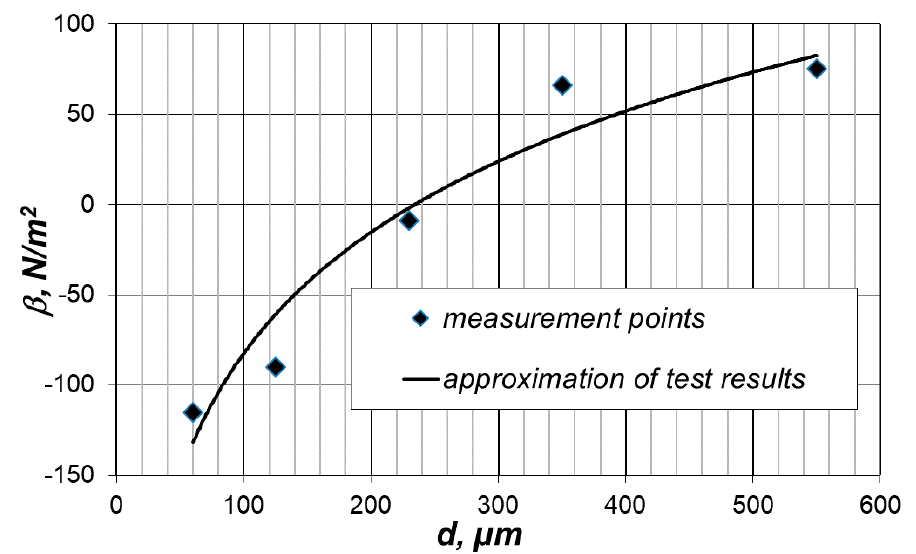
Figure 4. Value of the actual elastic limit stress as a function of the feed size (average grain size).